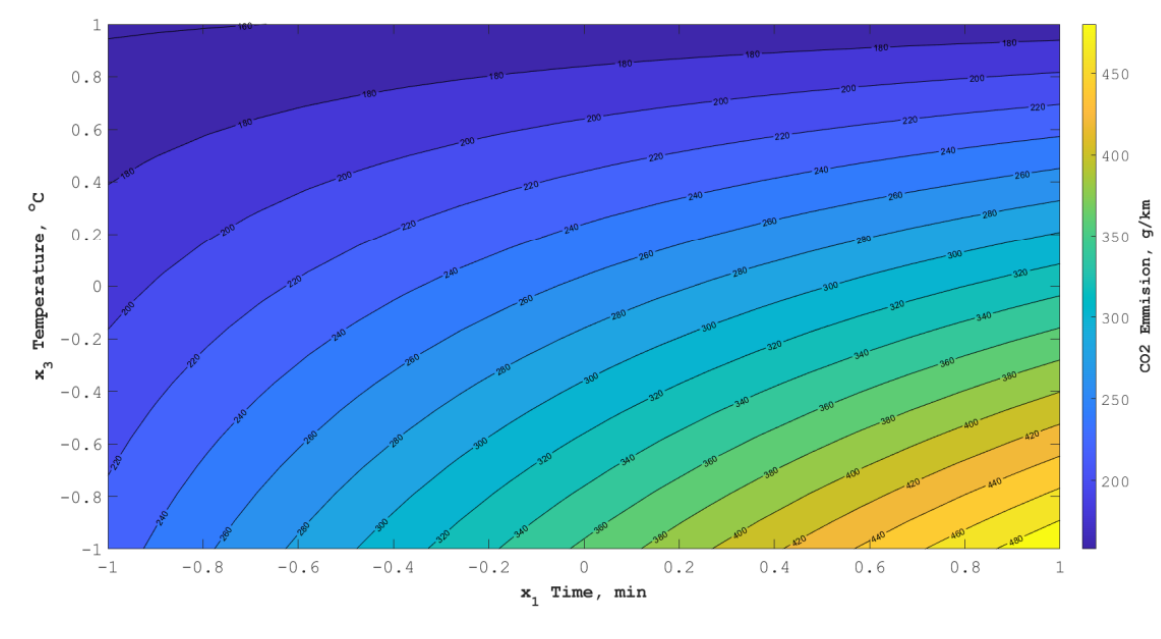
Figure 6. Change in CO 2 emissions depending on the variability of factors x 1 and x 3 for a vehicle (ICE) covering a distance of 3 km (x 2 = 0).